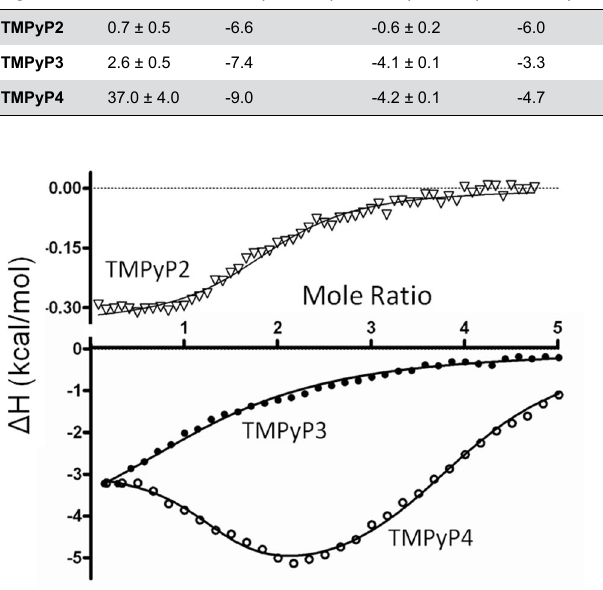
Figure 4. Typical ITC titration data ( points ) and nonlinear regression fits ( solid lines ) are shown for three titration experiments in which a dilute solution of porphyrin was added to a dilute solution of the annealed oligonucleotide in the calorimeter cell. The upper panel represents data for the titration of 39-mer Bcl-2 with TMPyP2 (Note the Y-axis is scaled from 0 to .3 kcals/mol). The lower panel represents data for the titration of 39-mer Bcl-2 with TMPyP3 and TMPyP4. The best fit parameters for the non linear regression analysis of these ITC data are given in Table 1.